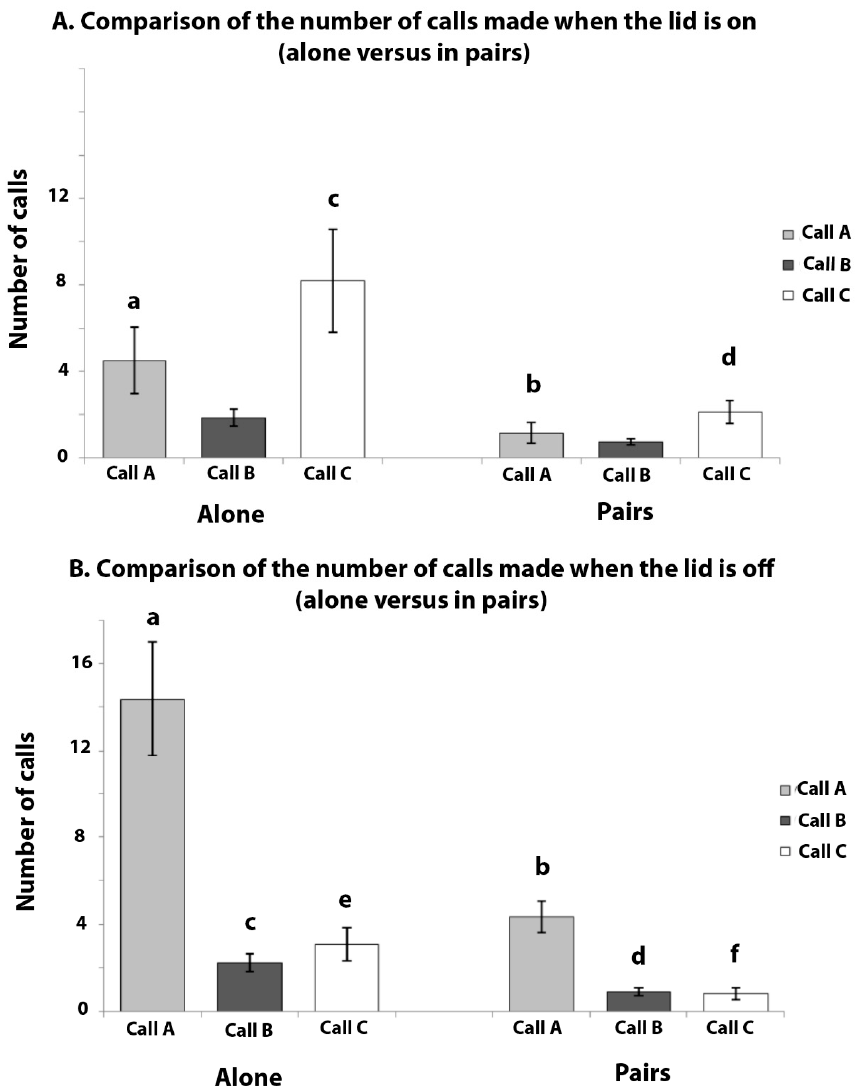
Figure 5. Comparison of the number of calls made in each 3 min period when tested alone compared to in pairs. ( A ) Lid-on condition. ( B ) Lid-off condition. Means are plotted and standard errors are indicated. Bars with ( a ) differ significantly from those with ( b ), ( c ) from ( d ), and ( e ) from ( f ). Although no C calls were elicited by banana or blueberries, the mean scores that are plotted included all of the presentations (insects and fruit). However, an analysis of the data did not include the zero scores for the banana and blueberries: see